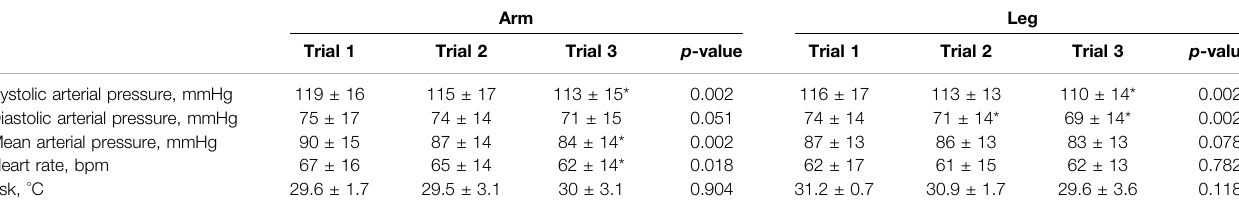
TABLE 2 | Absolute hemodynamic and skin microvascular responses.